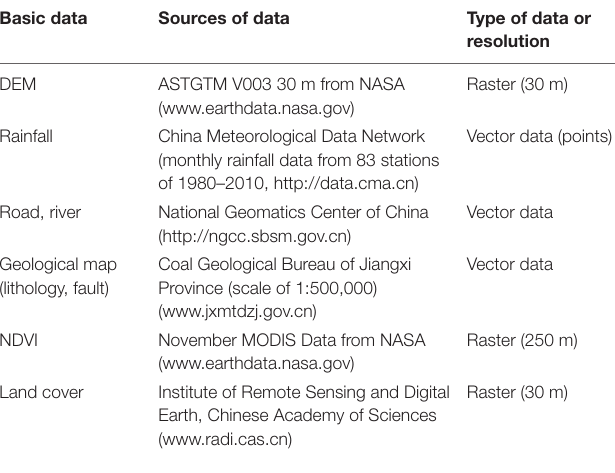
TABLE 1 | Data sources and data types of assessment